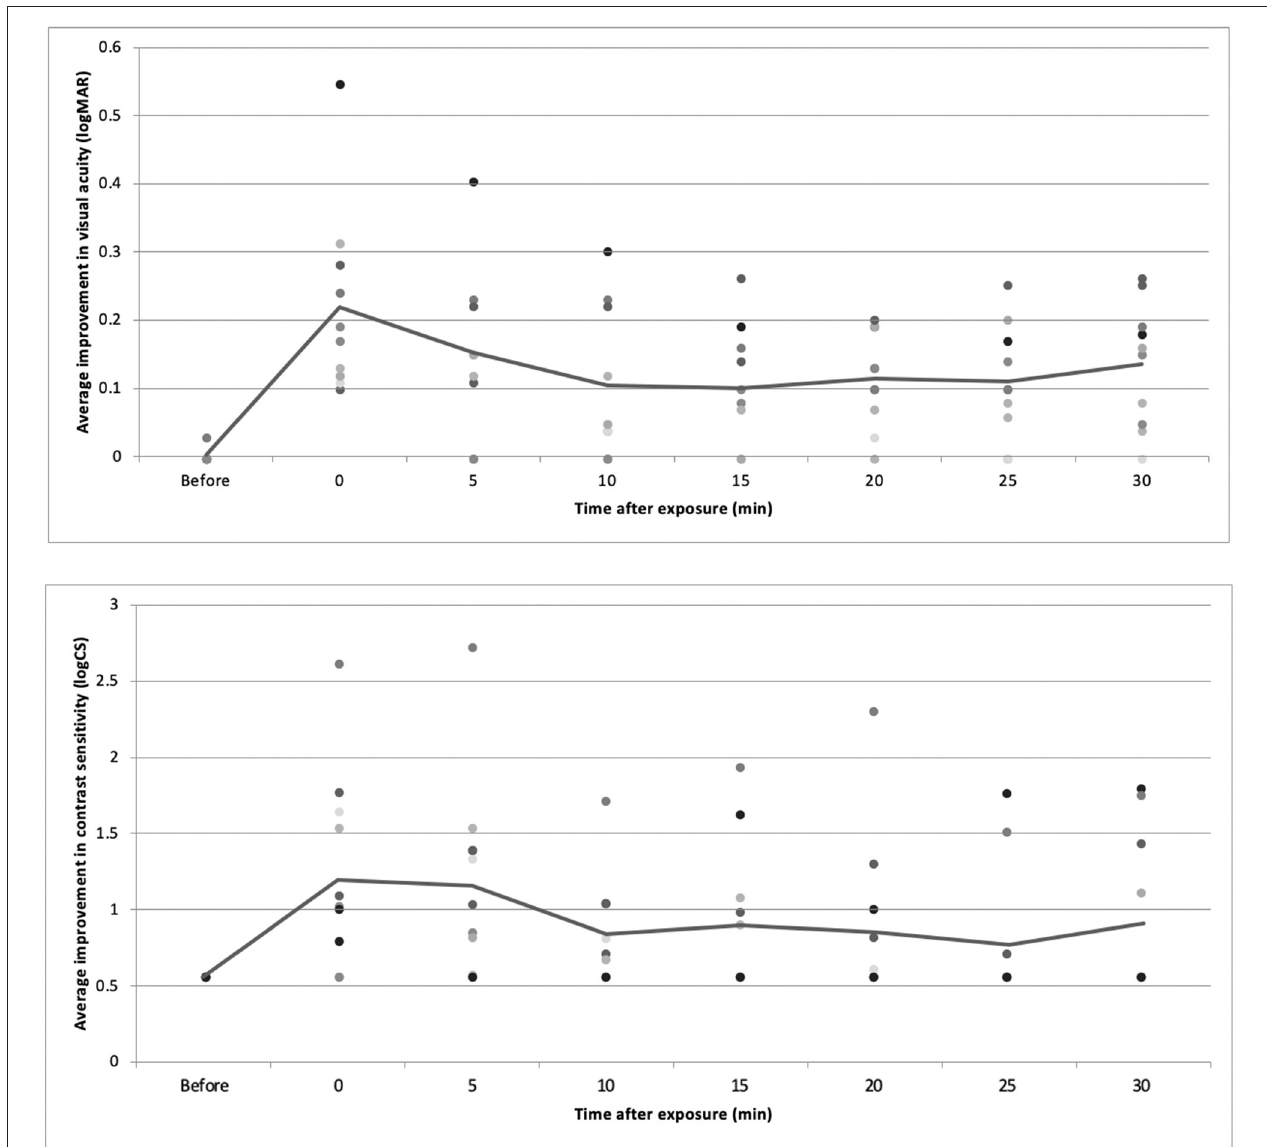
FIGURE 7 | The average change of VA and CS over